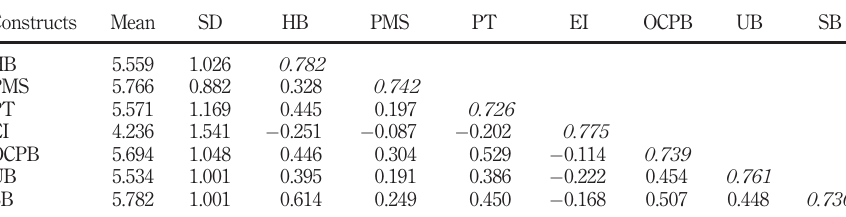
Table 3. Discriminant